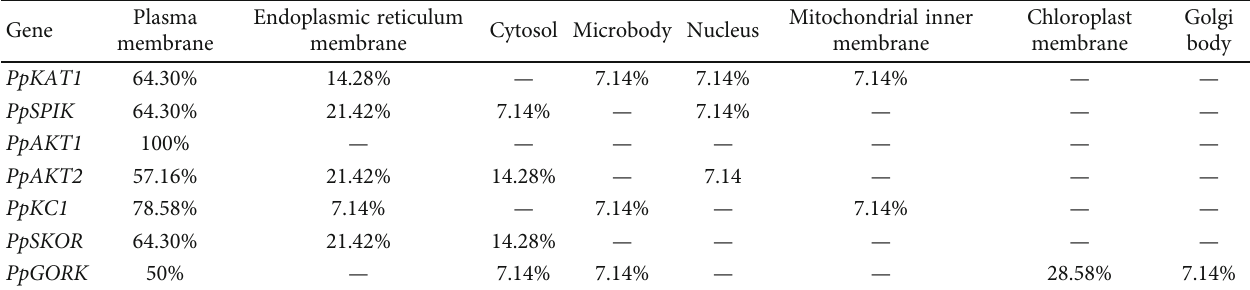
Table 3: Cis -acting elements analysis in the promoter regions of the peach shaker K + channel genes a .